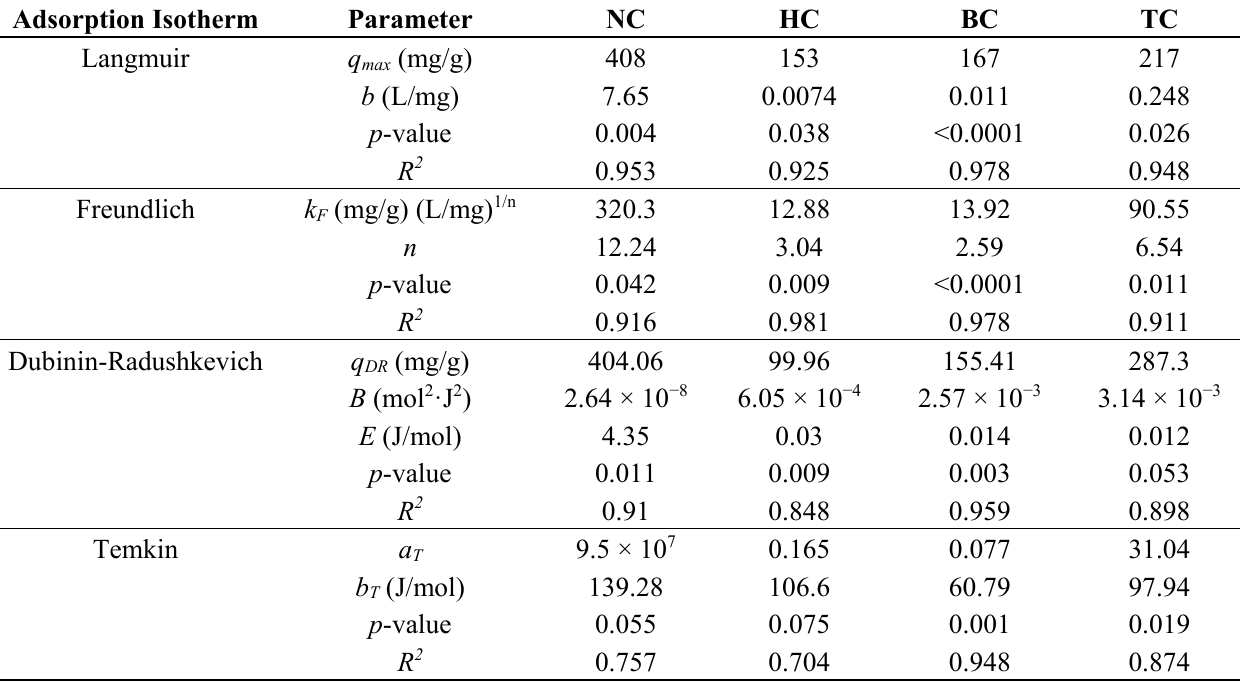
Table 1. Equilibrium constants and parameters for the Adsorption of MB onto the adsorbents. Adsorption